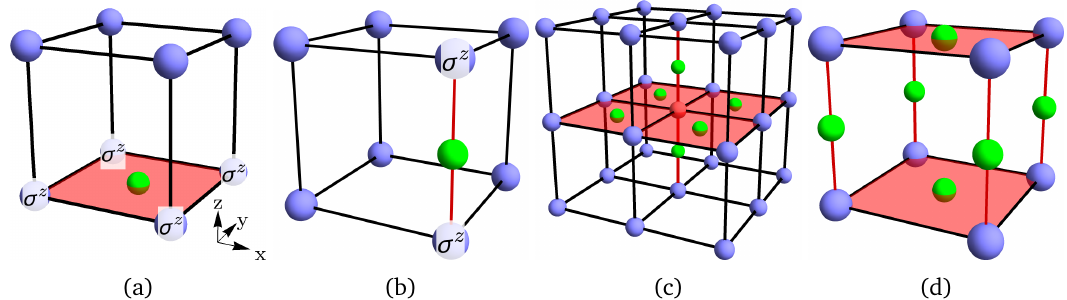
Figure 7: Gauging planar symmetry in X Z and Y Z directions only. (a-b) Minimal coupling terms. (c) The red vertex term in the center is included in four plaquette minimal coupling terms (red plaquettes) and two Z-axis terms (red edges). There- fore, the gauge symmetry term is a product of a σ x at the center (red sphere) and six τ x at the green spheres. (d) The flux term is a product of six τ z at the green